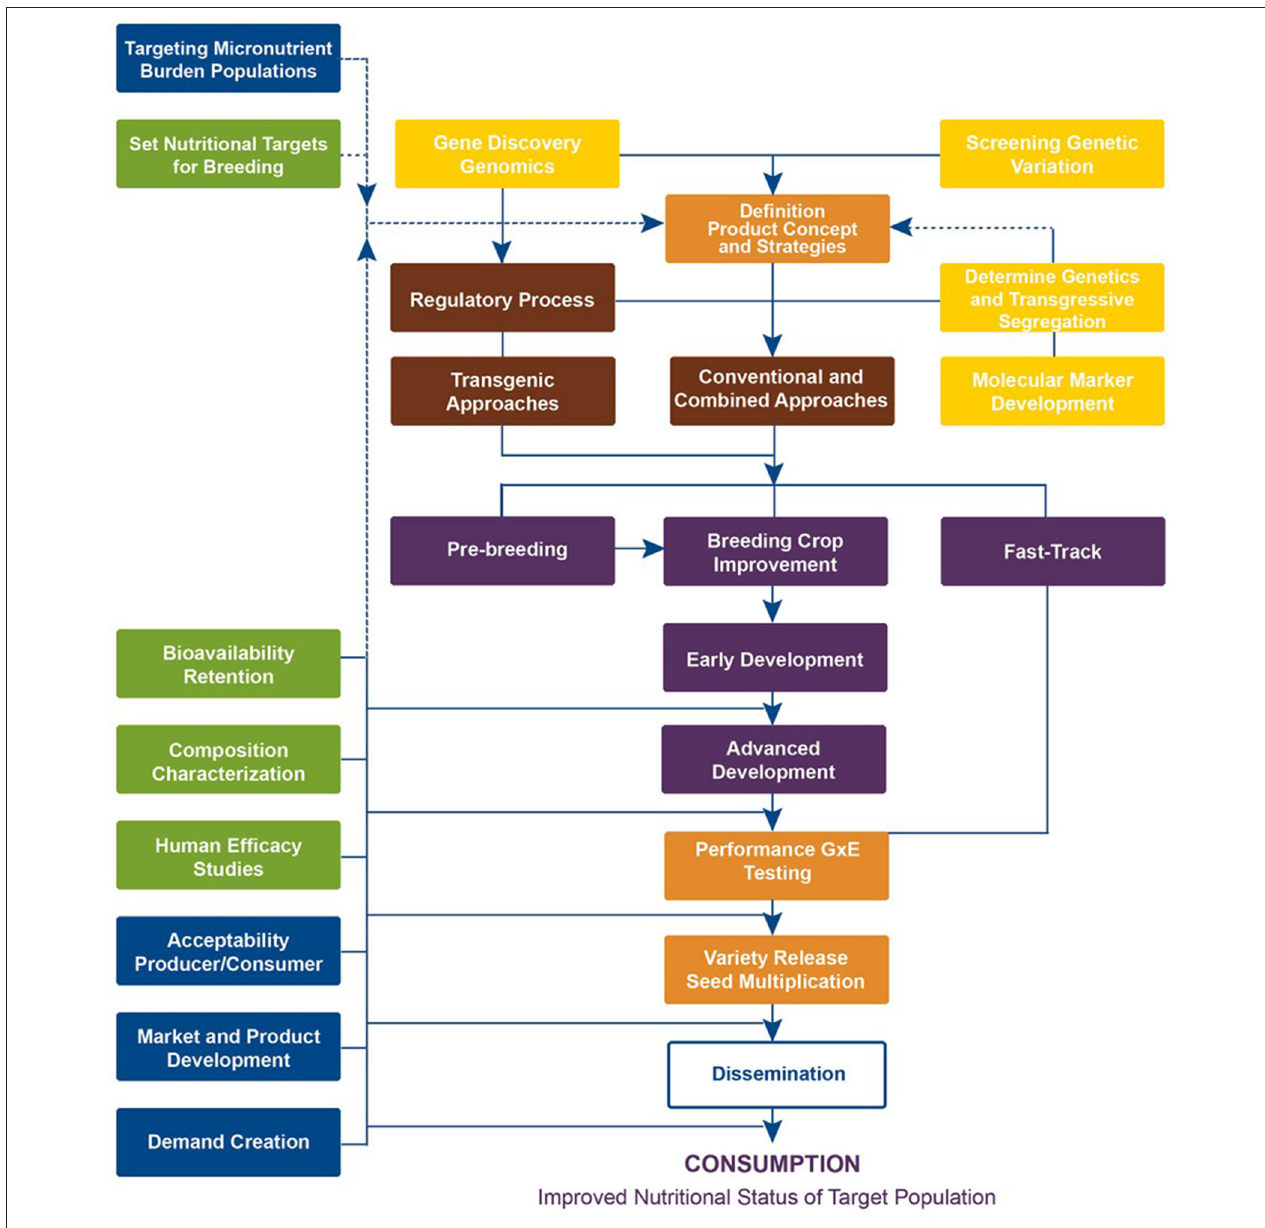
FIGURE 1 | Crop Development Conceptual Framework followed by HarvestPlus (source: www.harvestplus.org).